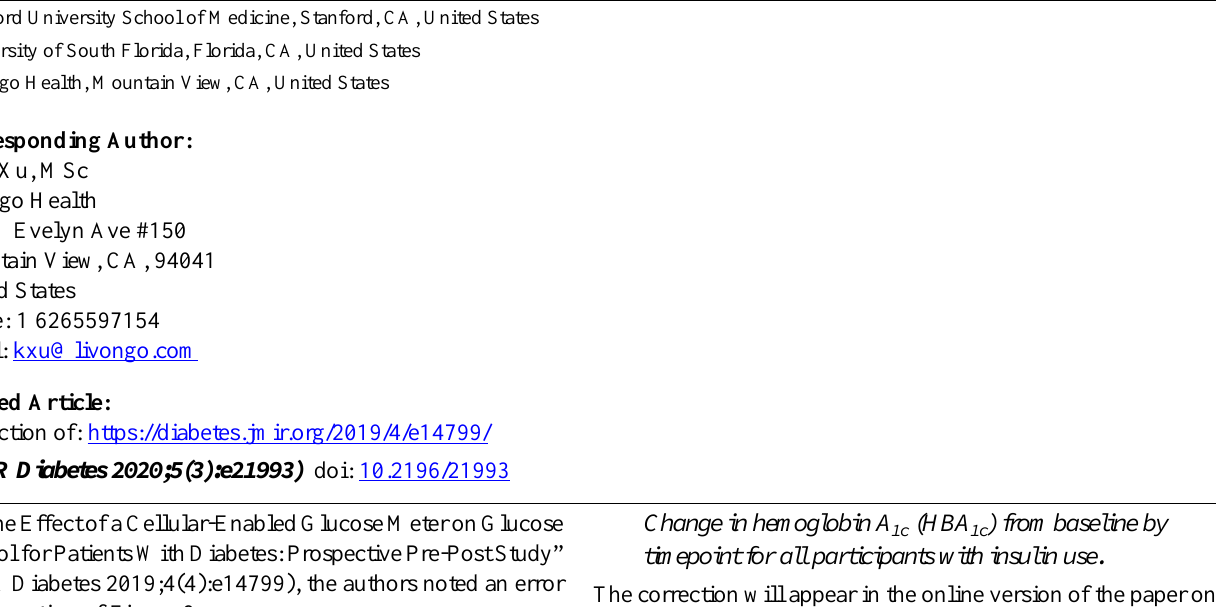
Figure Correction: The Effect of a Cellular-Enabled Glucose Meter